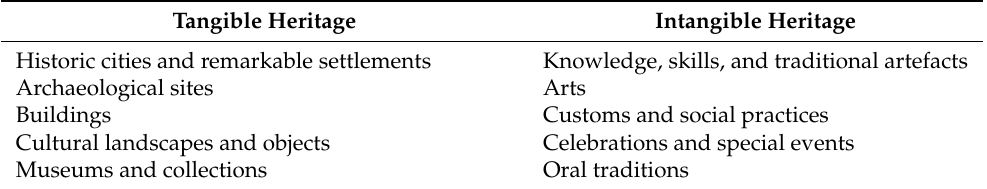
Table 1. Categories of tangible and intangible heritage used to record and map the eco-cultural